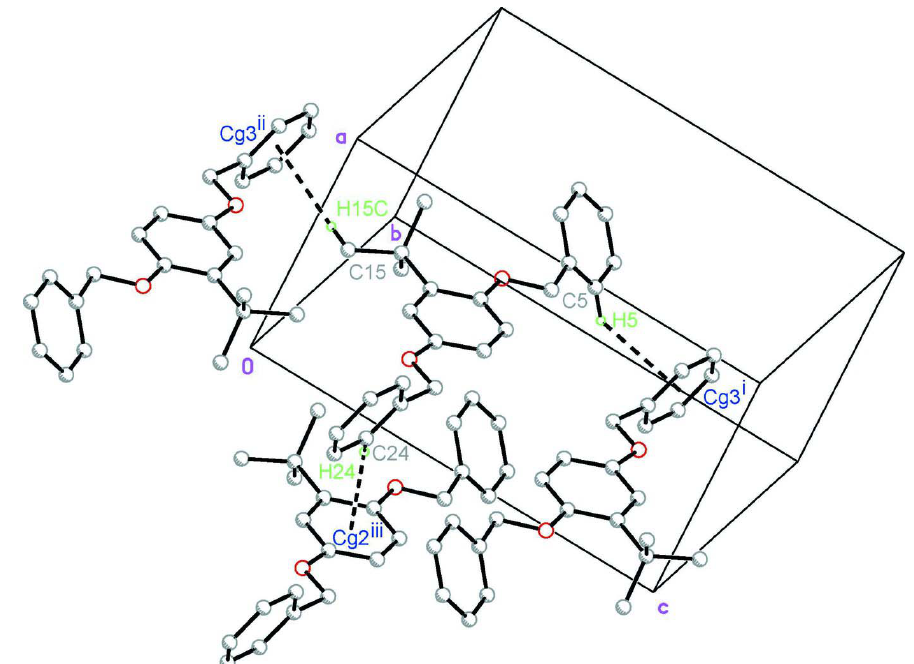
Figure 2 A packing diagram of (I) showing the intermolecular C—H··· π interactions (dashed lines). The H atoms not involved in H–bonds are omitted for clarity. Cg 2 and Cg 3 denote the centroids of the C8–C13 and C19–C24 phenyl rings respectively. [Symmetry codes: (i) - x , - y + 1, - z + 1; (ii) - x , - y + 1, - z ; (iii) x - 1, y , z